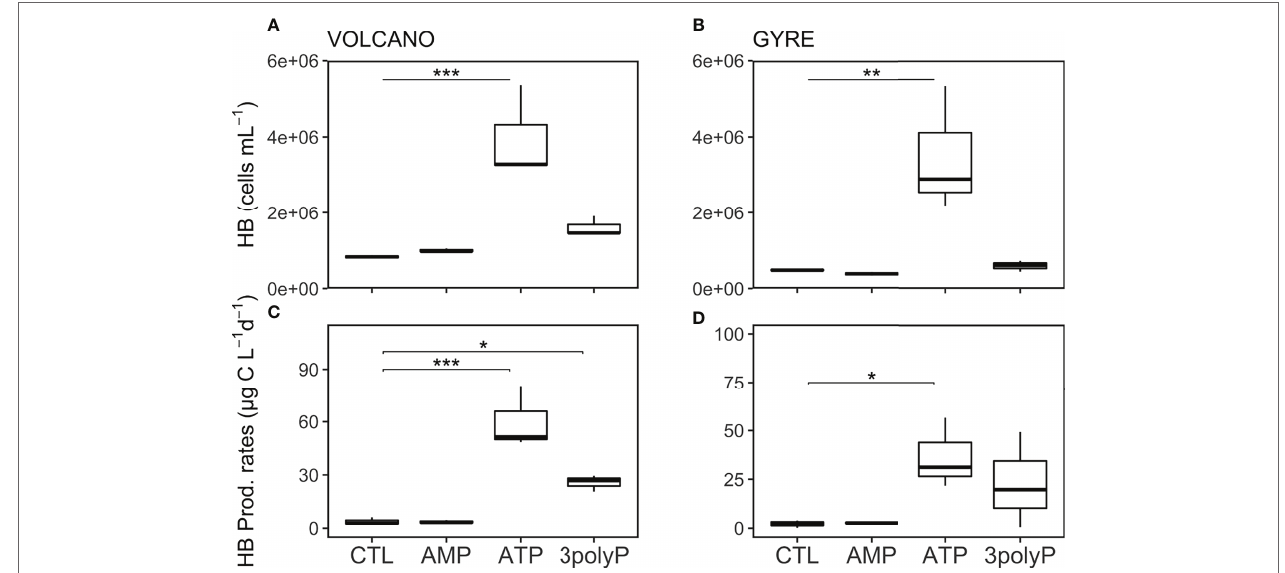
FIGURE 4 | Abundance and production rates of heterotrophic bacteria. Boxplots represent averaged heterotrophic bacteria (HB) abundance (A, B) and production rates (C, D) from each treatment triplicate at the volcano and the gyre station, respectively. Significant differences in cell abundance between the control and the DOP treatments were tested with the Dunnett’s Test and represented by the horizontal lines with significance codes (***p<0.001, **p<0.01,